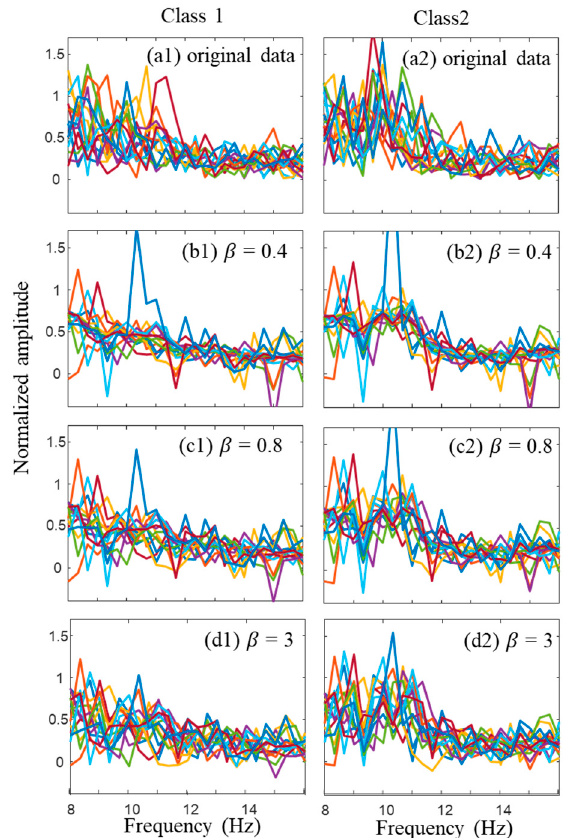
Figure 5. Artificial data generated with GNDv1. The y -axis represents the normalized amplitude in the frequency domain.